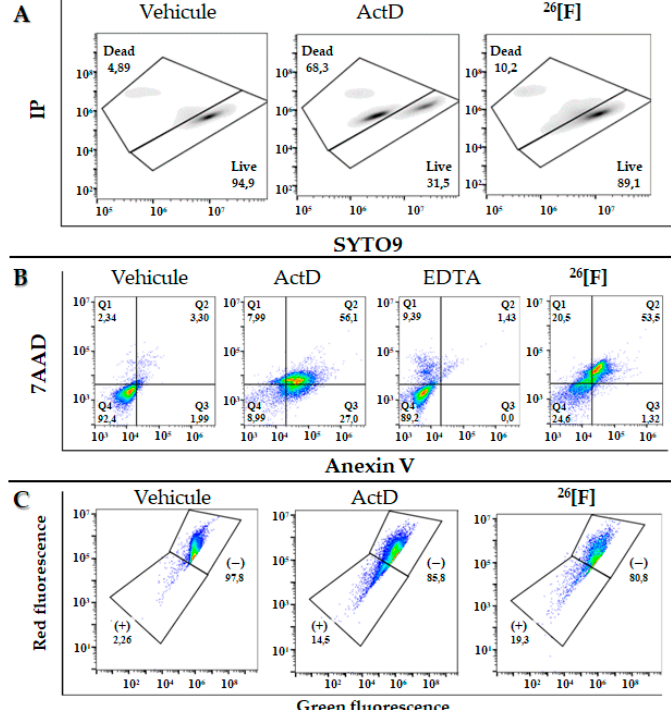
Figure 4. Flow cytometry assays. ( A ) MCF ‐ cells treated with the peptide 26 [F] (15 μ M) in the presence of PI and SYTO9 fluorophores. Negative control: cells without treatment, vehicle (DMEM); positive control: cells treated with Actinomycin ‐ D for 24 h. ( B ) MCF ‐ 7 cells treated with the peptide 26 [F] in the presence of Annexin V and PI fluorophores for 24h. Negative control: untreated cells, vehicle (DMEM); necrosis control: cells treated with 5 mM EDTA for 60 min; apoptosis control: cells treated with 15 μ M Actinomycin ‐ D for 24 h. ( C ) MCF ‐ 7 cells treated with the peptide 26 [F] in the presence of JC ‐ 1 fluorophore. Negative control: untreated cells, vehicle (DMEM); positive control: cells treated with 15 μ M Actinomycin ‐ D for 24 h.